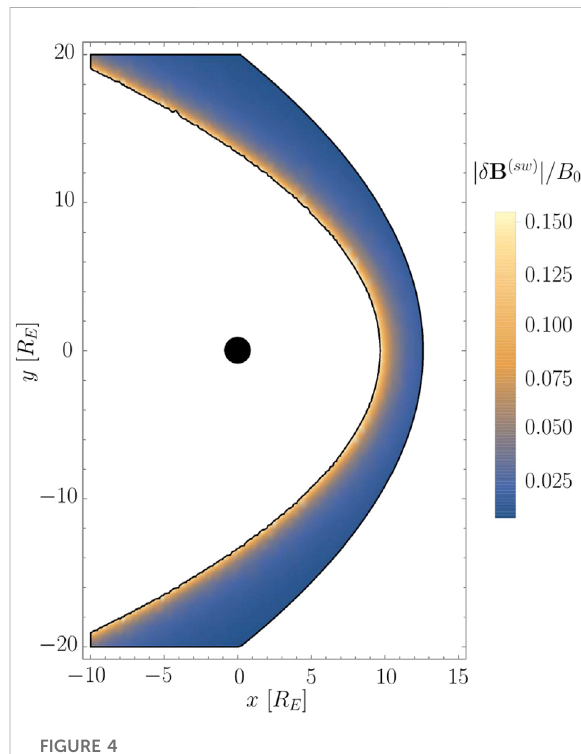
FIGURE 4 Relativeerrorofthereconstructedamplitudeoftheupstream fi eld resulting from defectively determined standoff distances R mp and R bs